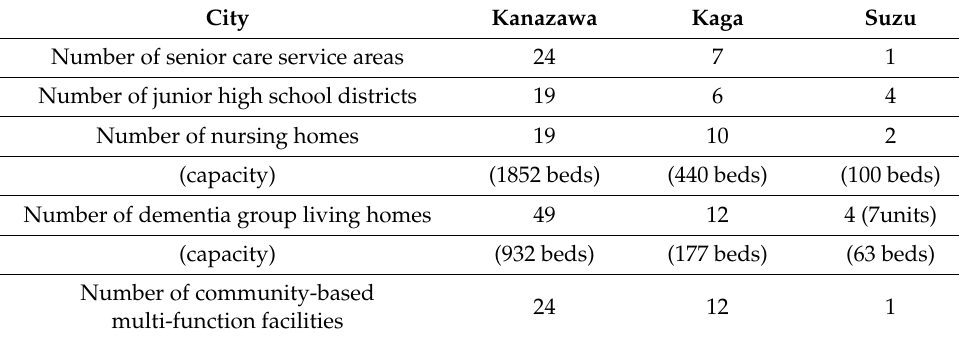
Table 2. Numbers of senior care-service areas, junior high school districts, and care facilities in three cities.